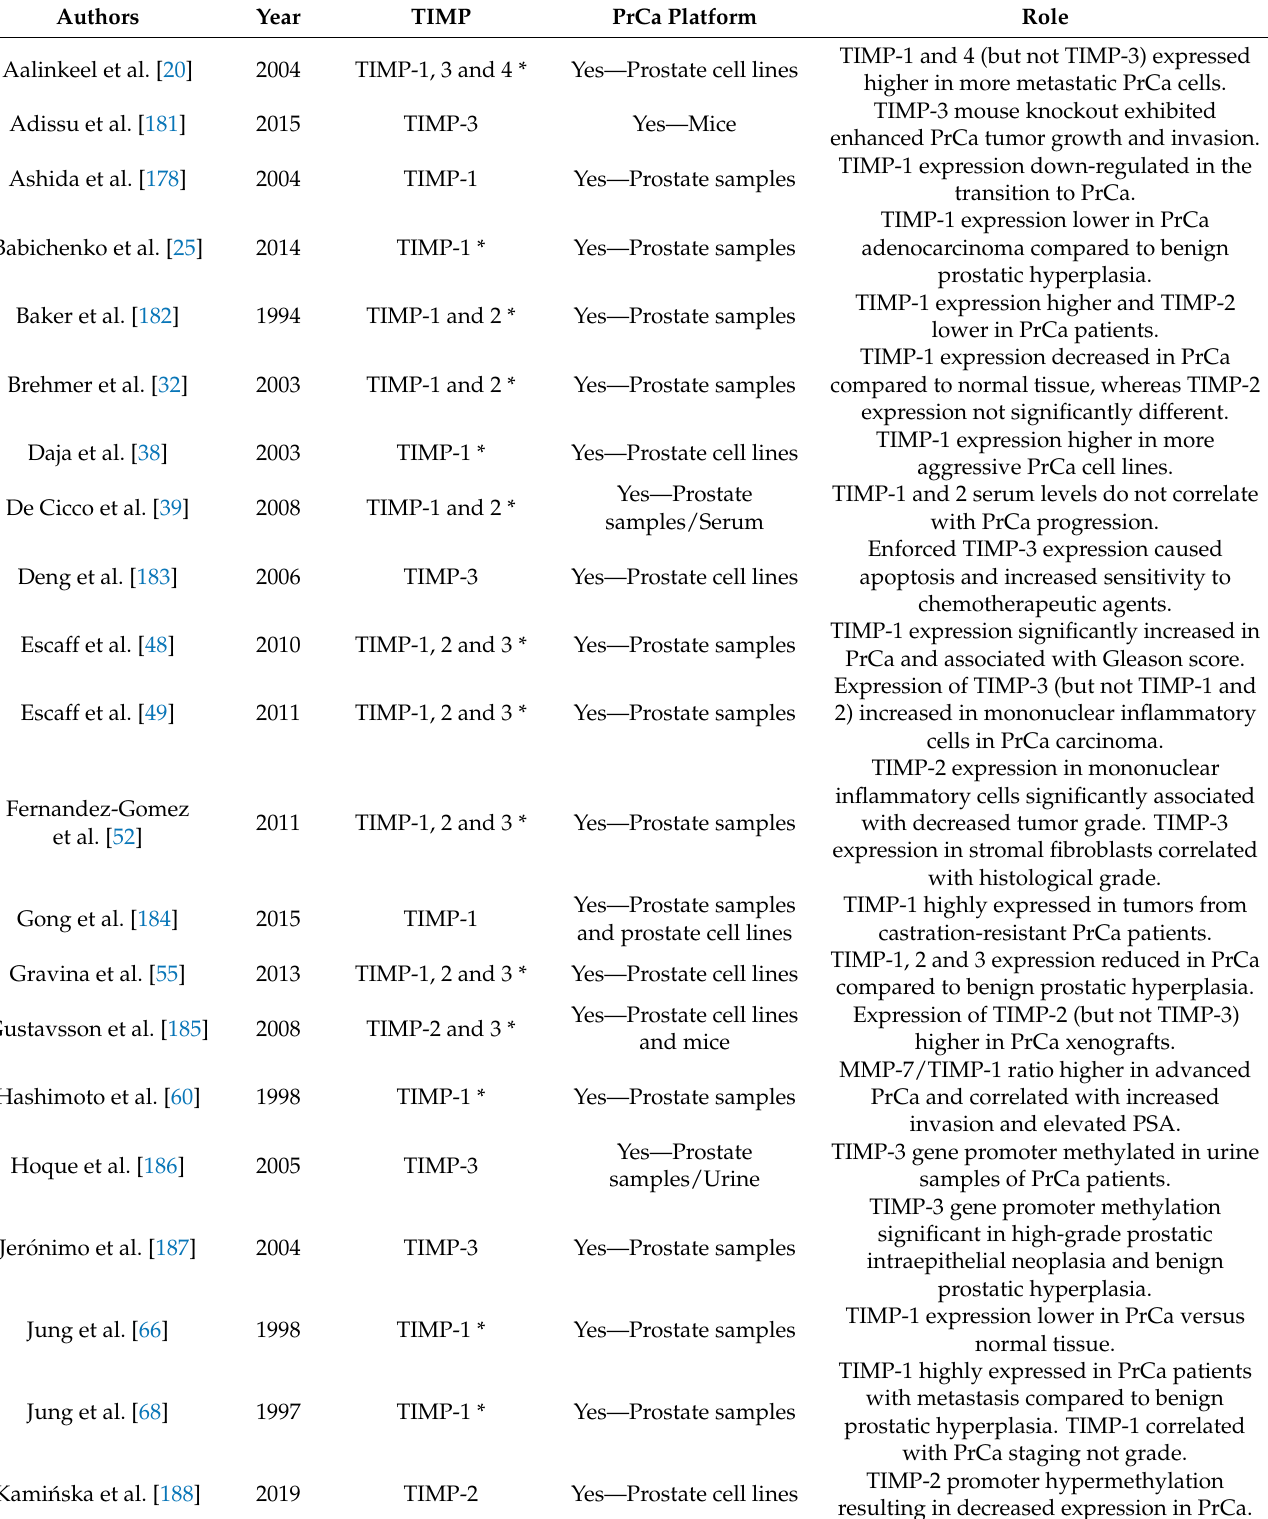
Table 3. Studies on the Tissue Inhibitor of Metalloproteinases (TIMPs) in